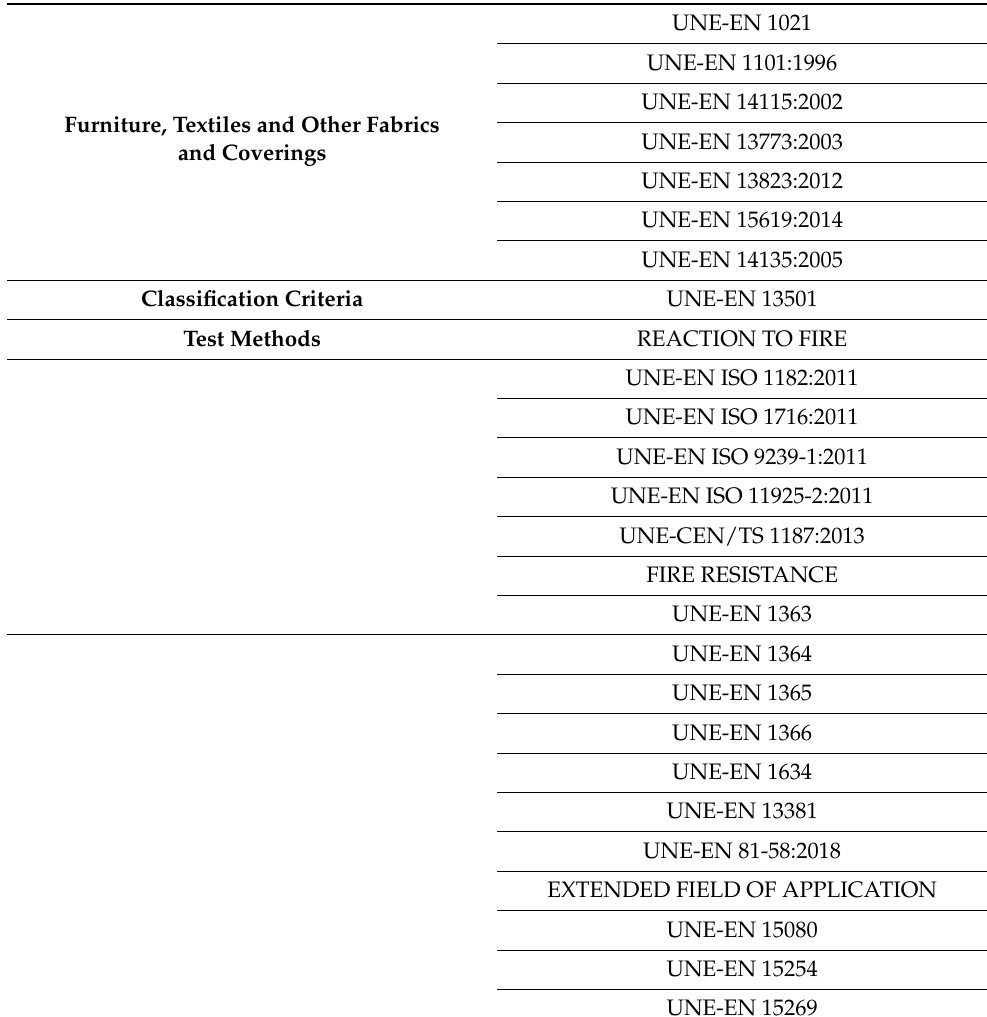
Table 8. Summary of harmonized European standards and Spanish referred to by the Basic Document (DB) SI in the Annexe G. Adapted by the